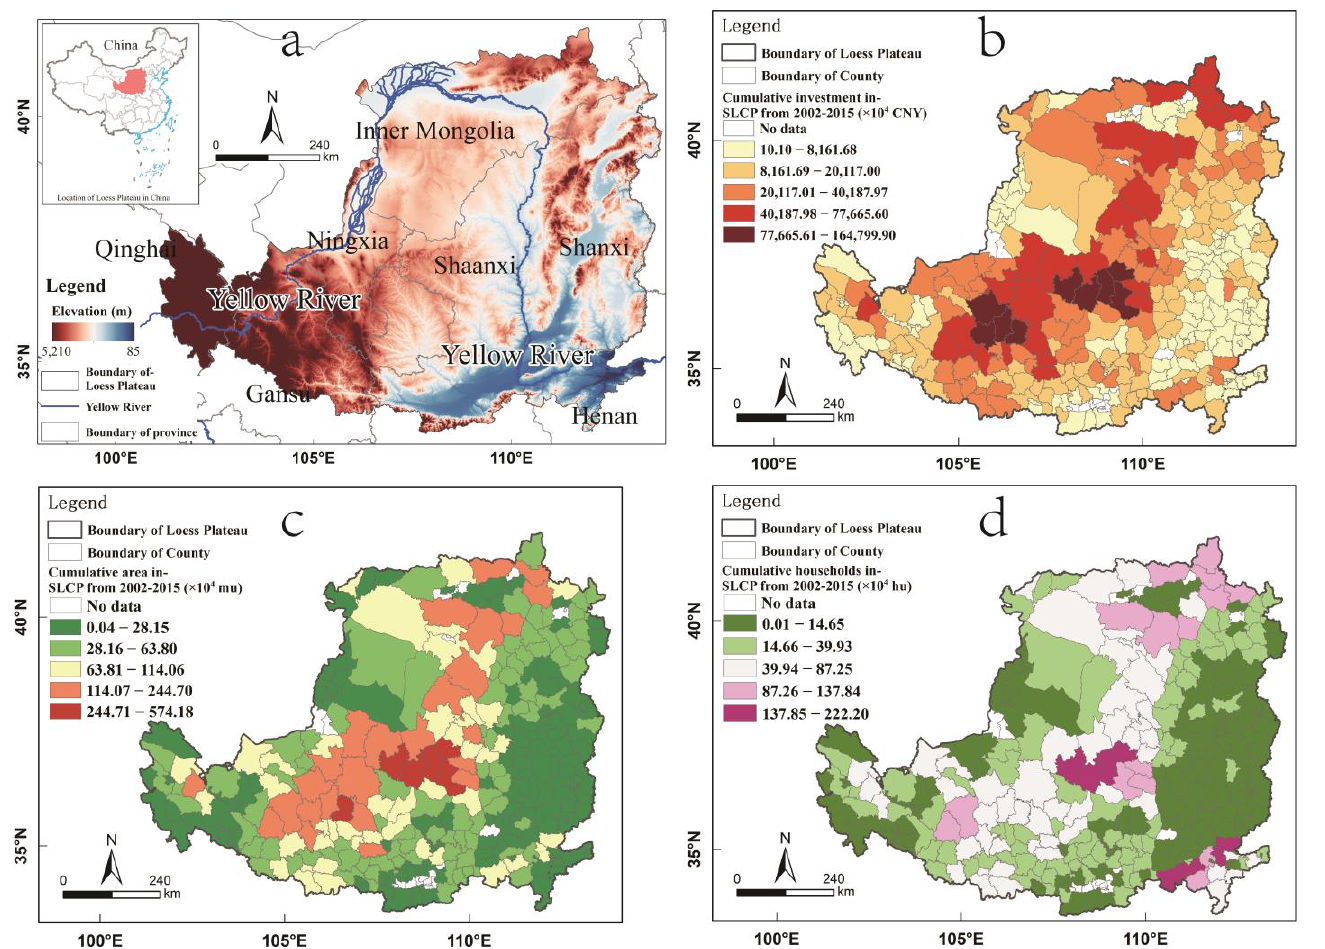
Figure 1. ( a ) Location and topography of the LP; ( b ) cumulative investment in SLCP; ( c ) cumulative area in SLCP, and ( d ) cumulative households in SLCP, 2002 to